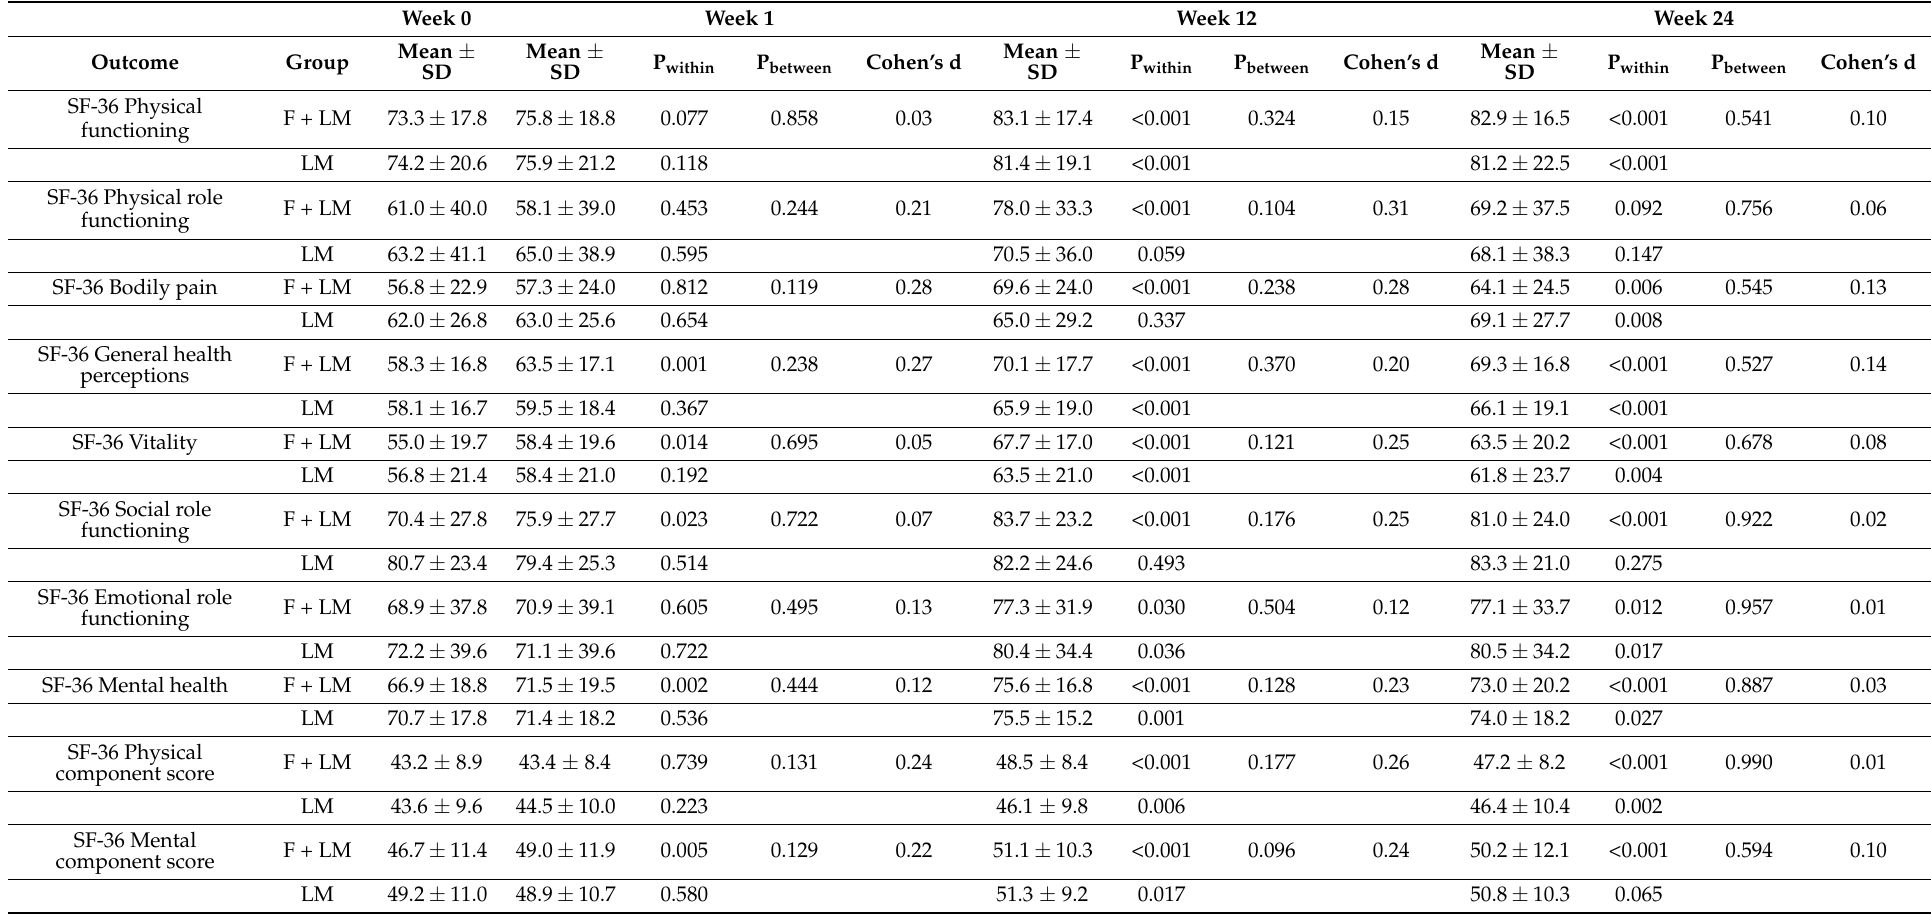
Table 2. Effects of the study interventions on patient-reported outcomes. Bold p -values indicate significant group differences ( p <